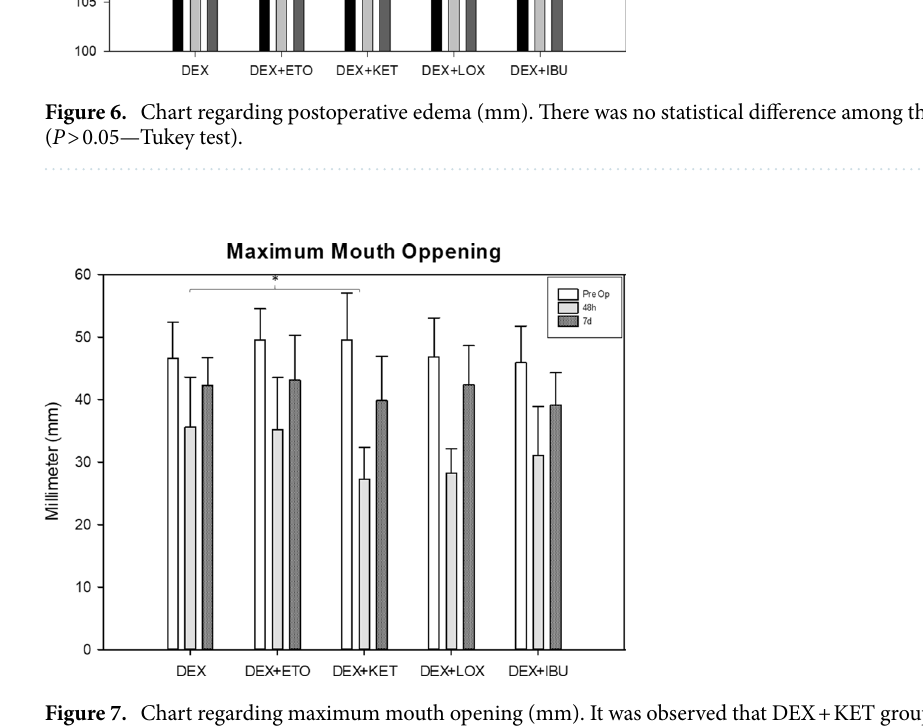
Figure 7. Chart regarding maximum mouth opening (mm). It was observed that DEX + KET group showed significant lower MMO at 48 h postoperative compared to DEX group ( P < 0.05—Tukey test). Other groups showed no significant difference on postoperative